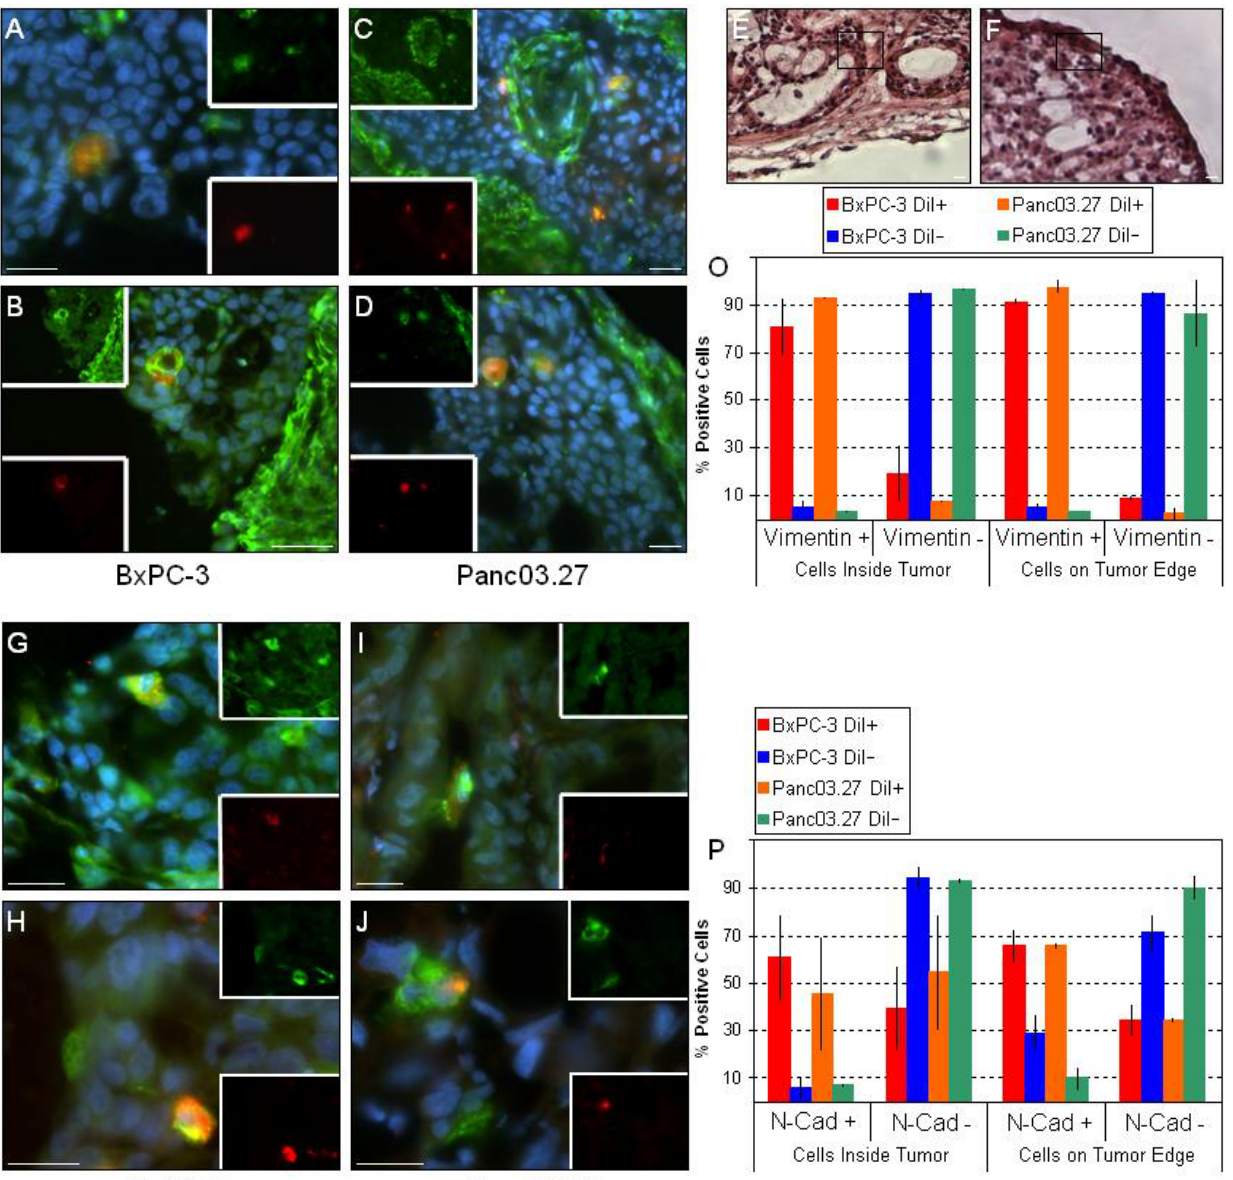
Figure 3. DiI+/SCC undergo EMT in vivo. Sections from BxPC-3 and Panc03.27 tumors were stained against the mesenchymal markers vimentin ( A - D ) and N-cadherin ( G - J ) and the epithelial marker E-cadherin ( K - N ) (Alexa Fluor 488, green). DiI+/SCC (red) located within the tumor ( A and C ; G and I ; K and M ) or on the tumor edge ( B and D ; H and J ; L and N ) stained positive for the mesenchymal markers and negative for epithelial markers, suggesting an EMT. ( E and F ) corresponding H&E sections for the vimentin stained sections B and D , respectively. The boxed region represents the area displayed in B and D , confirming their location on the tumor edge. ( O ) Graphical representation of statistical analysis for vimentin. Nearly all DiI+/SCC were vimentin +, while DiI-/FCC were mainly vimentin -. ( P ) Graphical representation of statistical analysis for N-cadherin. More than half of the DiI+/SCC were N-cadherin +, while most of the DiI-/FCC remained N-cadherin -. ( Q ) Graphical representation of statistical analysis for E-cadherin. Almost all DiI+/SCC were E-cadherin – while DiI-/FCC remained E-cadherin +. Bars represent 20